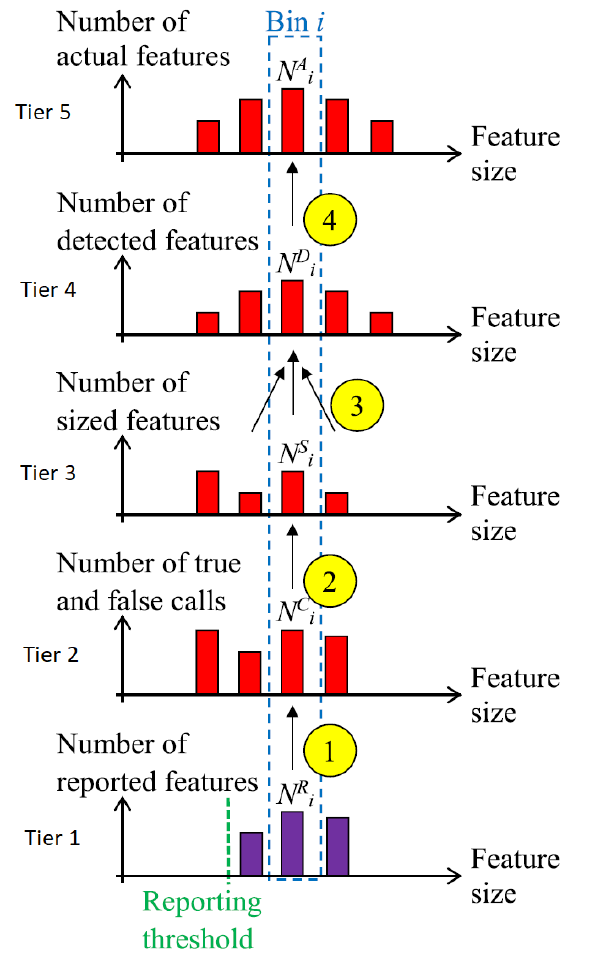
Figure 60. The hierarchical process (bottom to top) to determine determining the distribution of the number of actual features in histograms (each group of features from the similar range of feature size is represented in a bar, which is referred to as a bin) from the number of reported features provided by the data from in-line inspection techniques. Reprinted from Reliability Engineering & System Safety, Volume 180, Dann, M.R.; Maes, M.A. Stochastic Corrosion Growth Modelling for Pipelines Using Mass Inspection Data, Page 245–254, Year 2018 with permission from Elsevier